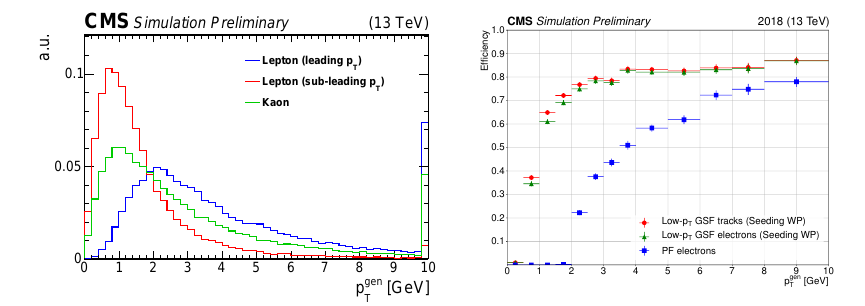
Figure 3. Left panel: Generator-level p T distributions of the daughter particles from signal-side B + → K + (cid:96) + (cid:96) − decays. Right panel: Reconstruction e ffi ciency curves for standard CMS electron candi- dates (blue squares) and for GSF tracks (red circles) and electron candidates (green triangles) from the new algorithm as a function of the generator-level electron p T . Taken from Ref. [25].